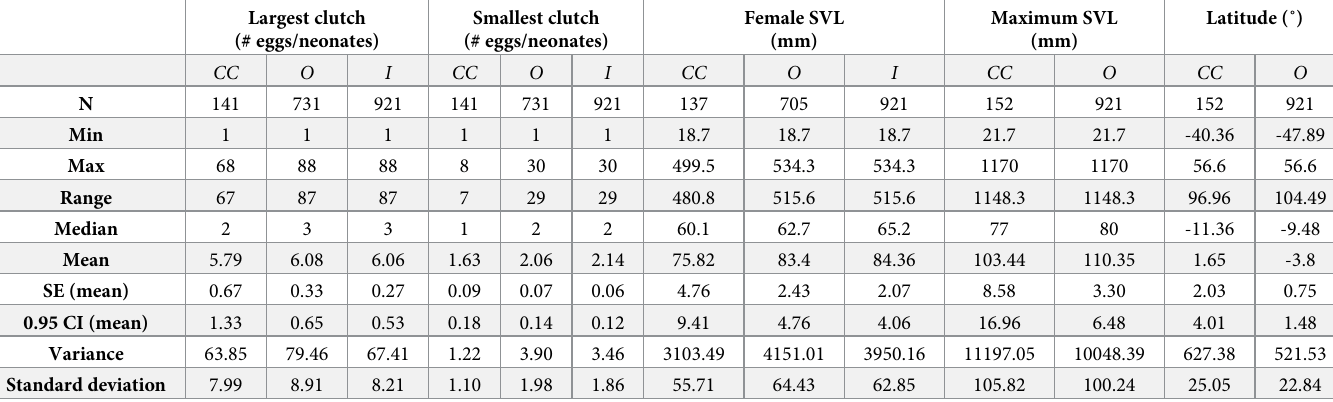
Table 1. Summary statistics for the complete-case data, original data, and original data with imputed values. Largest clutch Smallest clutch (# eggs/neonates) (#